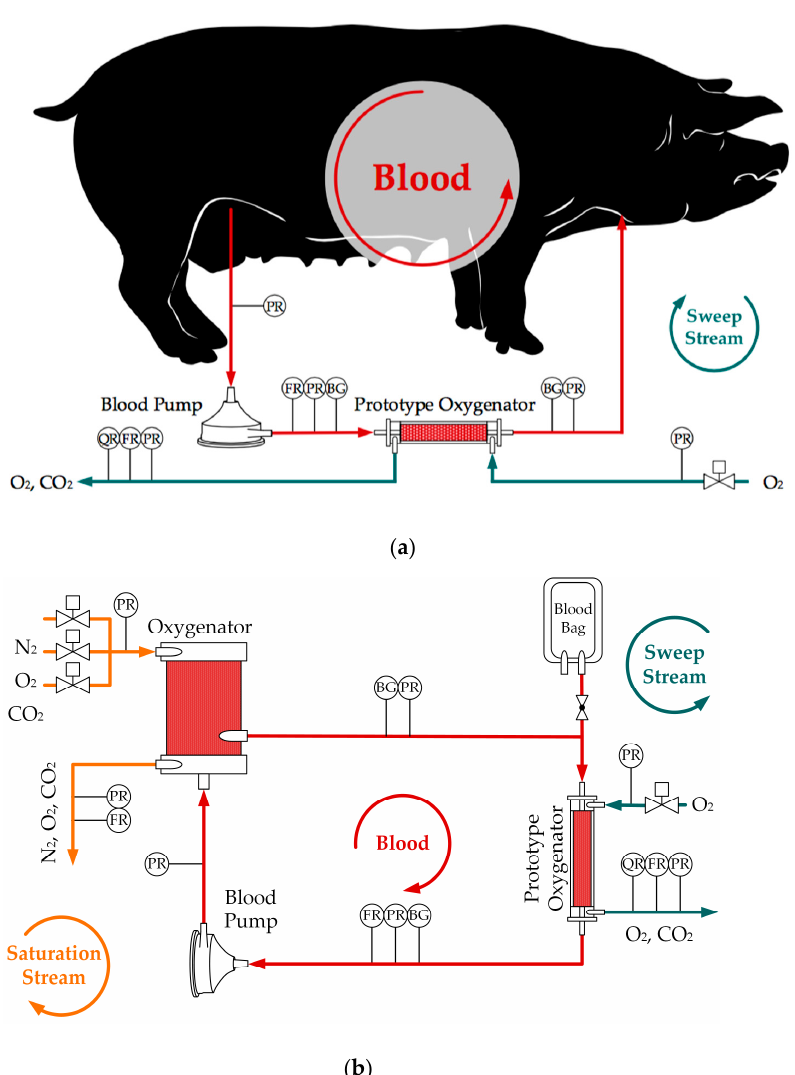
Figure 4. Schemes of the test setups showing the prototype oxygenator, blood pump, pressure sensors (PR), flow rate sensors (FR), sample ports for the blood gas analyzer (BG) and CO 2 concentration sensor (QR): ( a ) scheme of in vivo loop—by Lukitsch et al. [16] (CC BY 4.0); ( b ) scheme of in vitro loop—by Lukitsch et al. [8] (CC BY 4.0).